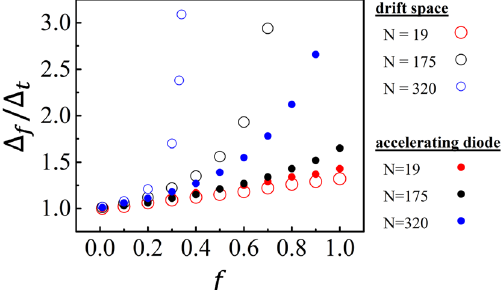
FIG. 3. The dependence of Δ (in terms of Δ ) as a function of f t ¼ 2 . 16 ½ ps (cid:2) for N ¼ 19 (red), 175 (black) and 320 f for Δ t (blue). The open circles are for drift space, and the solid circles are for accelerating diode.